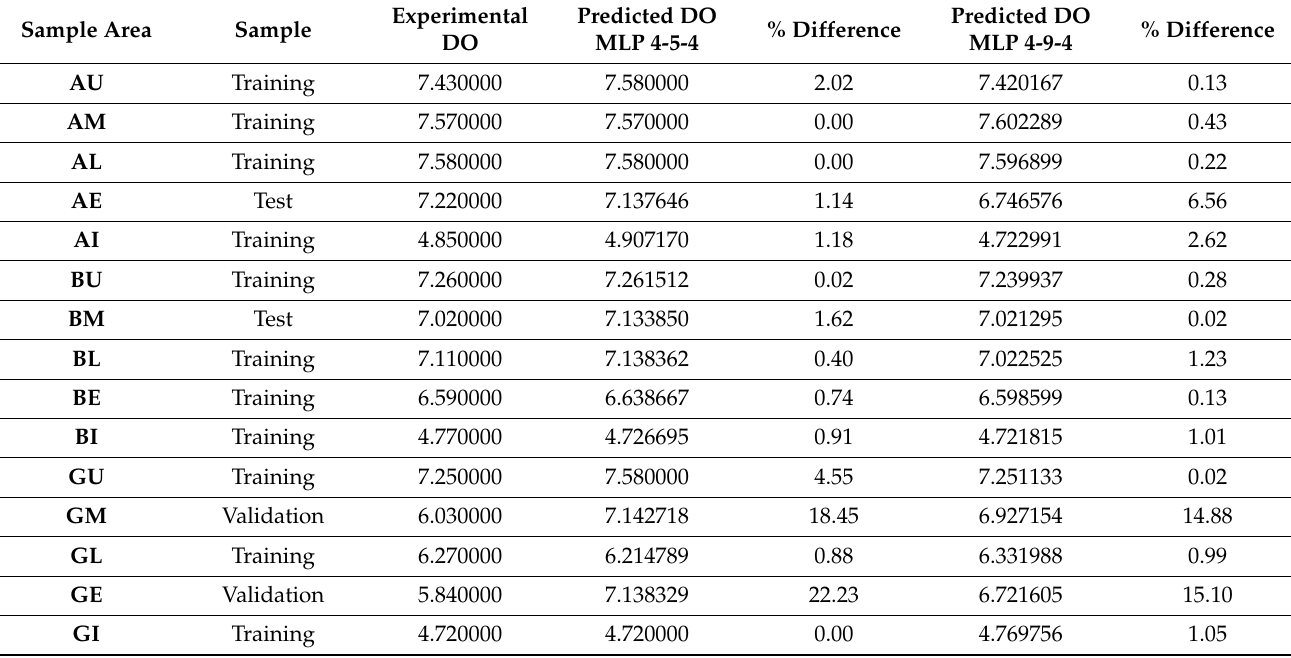
Table 7. Experimental and predicted values for dissolved oxygen generated by MLP 4-5-4 and MLP 4-9-4 networks. Sample: Train, Test,